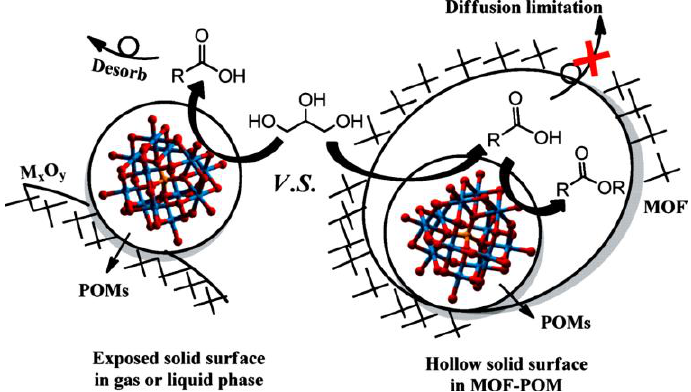
Figure 11. Diffusion limited glycerol transformation over a POMs@HKUST-1 hybrid catalyst. Reprinted with permission from reference [121]. Copyright 2015 Royal Society of Chemistry.